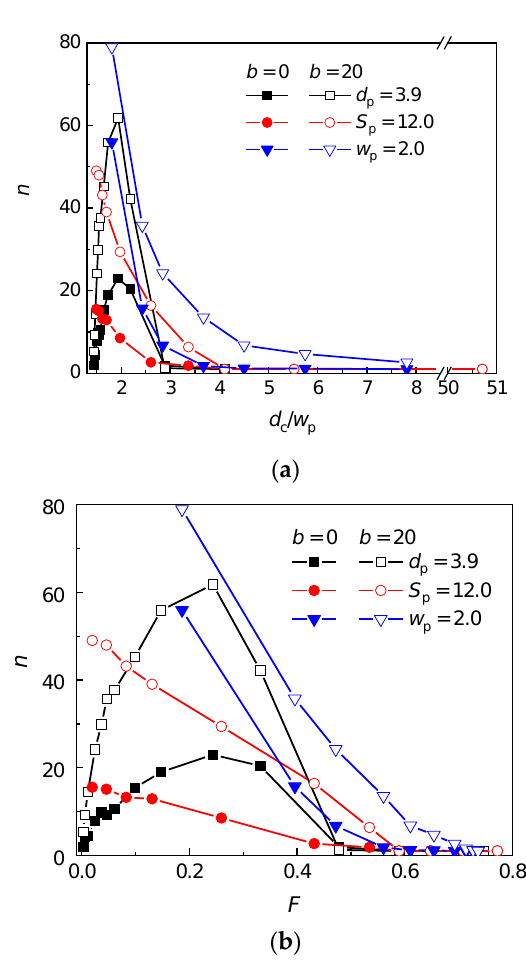
Figure 2. Occupation number of a flexible ( b = 0) and semiflexible ( b = 20) chain in a post array with the geometry variation at constant post diameter d p , post separation S p , and passage width w p as a function of the d c / w p ratio ( a ) and the volume fraction of posts F ( b ).